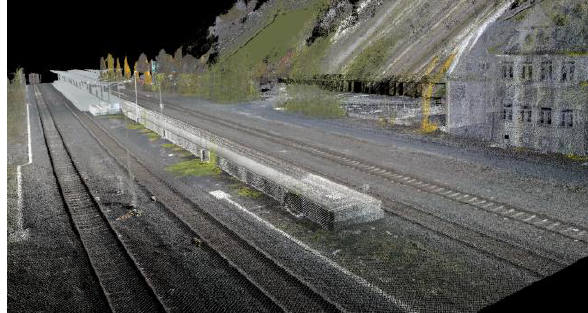
Figure 21: Coloured point cloud of a small train station